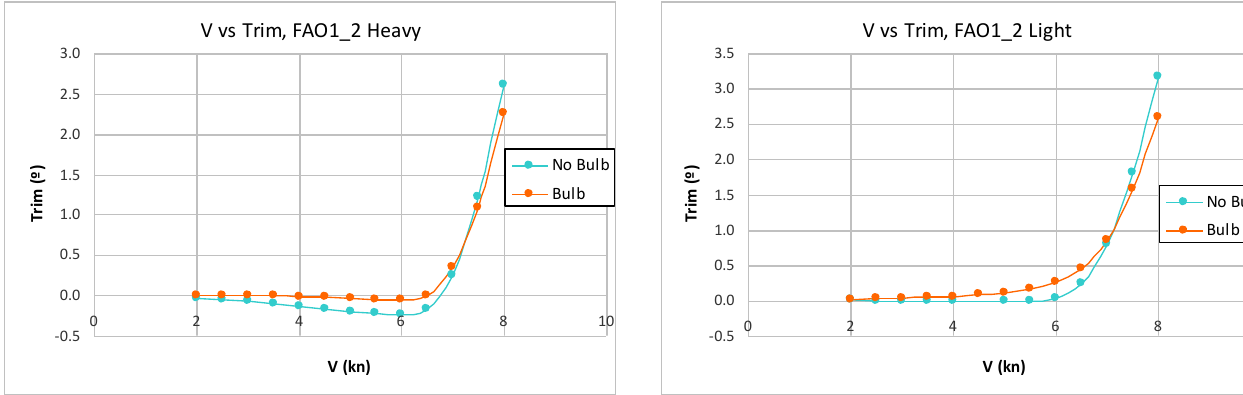
Figure 25. Effect on trim, FAO1 vs. FAO2.